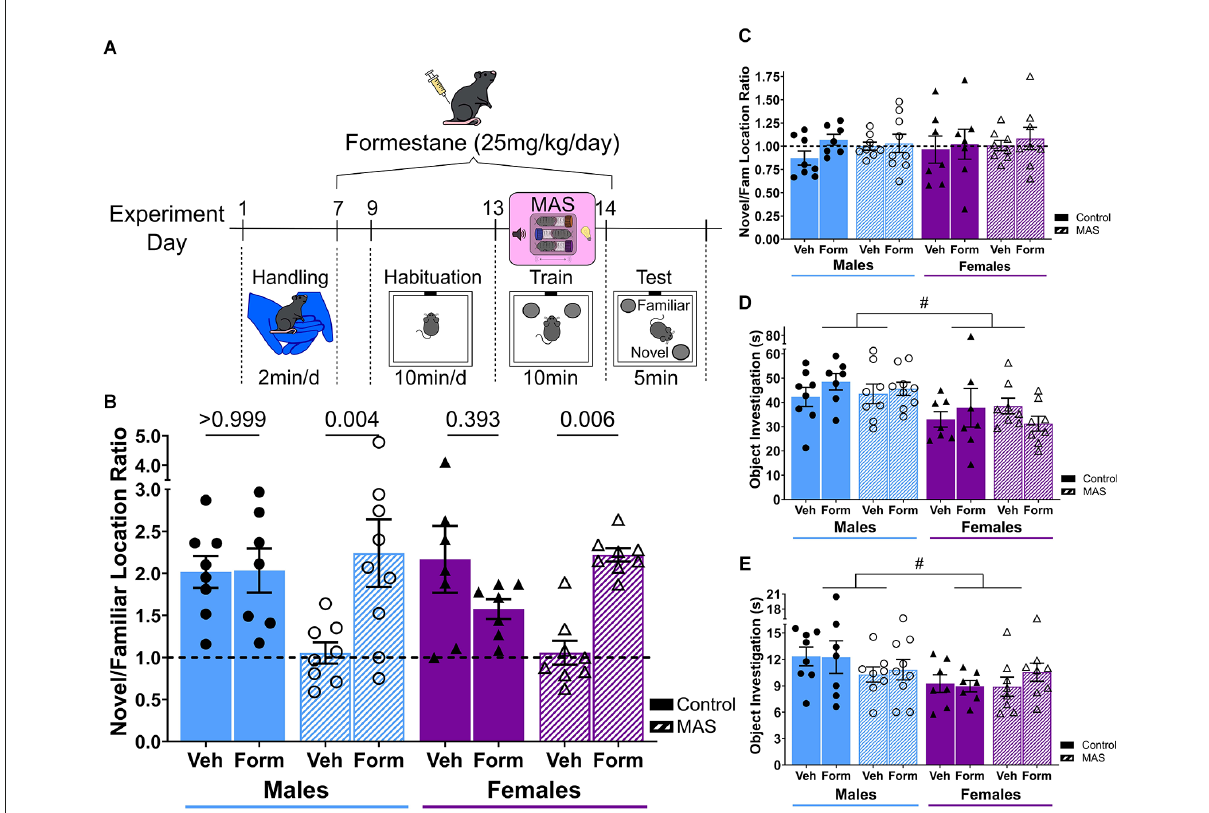
FIGURE1 Aromatase inhibition prevents MAS-induced object location memory deficits in male and female mice. (A) Mice were handled, then given daily, subcutaneous administrations of the aromatase inhibitor formestane for 1 week leading up to MAS, concurrently with habituation to the object location memory (OLM) apparatus. Two hours after MAS, mice were trained with two identical objects for 10 min then tested 24 h later. (B) During the 5 min OLM test, vehicle treated male and proestrus female mice exposed to MAS had poor spatial memory compared to controls, however, male and female mice treated with formestane prior to MAS preferentially explored the moved object ( n = 7–9/group). (C) During OLM training, mice did not display any object bias regardless of group assignment. (D) During OLM training, time spent investigating the objects did not vary with drug or stress, but males had longer total investigation compared to females. (E) Likewise, during OLM testing, time spent investigating the objects did not vary with drug or stress, but males had longer total investigation compared to females. # Main effect ( p < 0.05). Post test p-values are provided above the corresponding comparisons. Individual points represent individual mice. Data are presented as mean ±